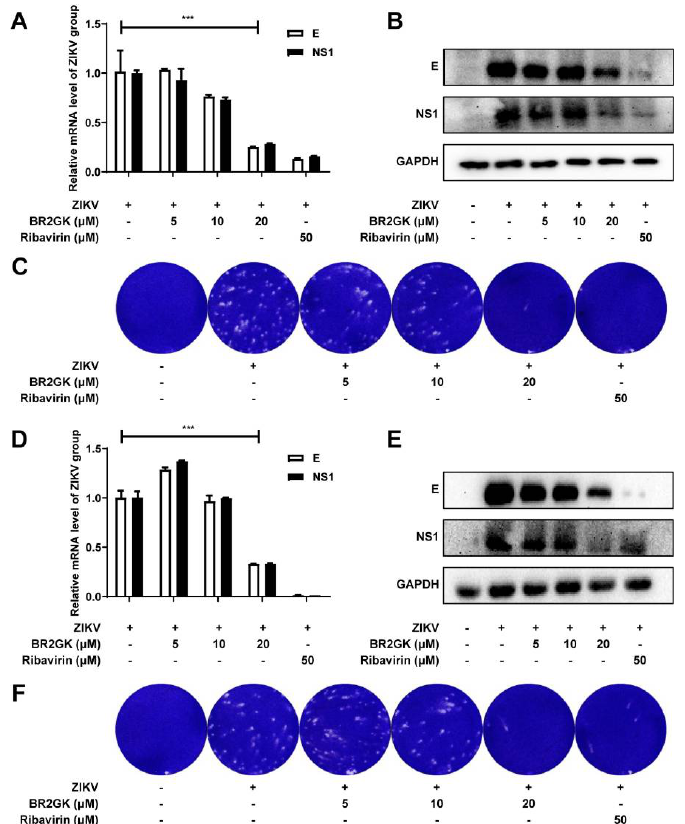
Figure 5. BR2GK inhibited ZIKV infection in human cell lines. ( A – C ) BR2GK inhibited ZIKV